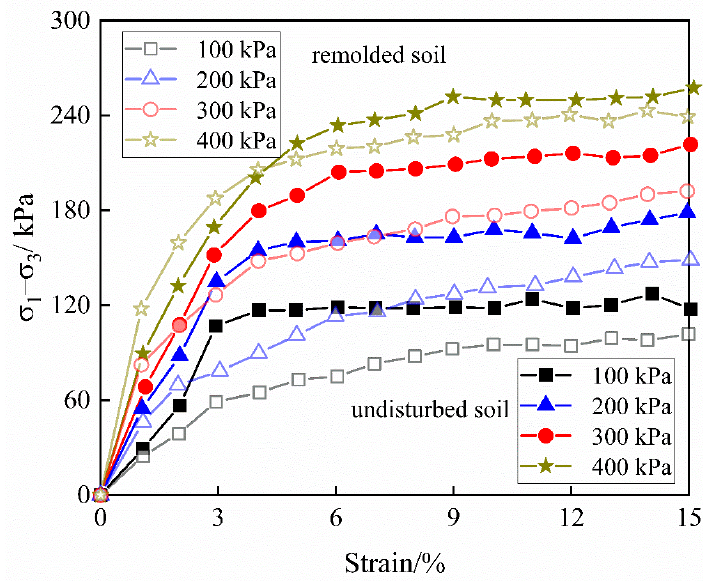
Figure 4. Stress–strain curves of undisturbed and remolded soils. Table 2. Calculated cohesion and shear resistance angles.